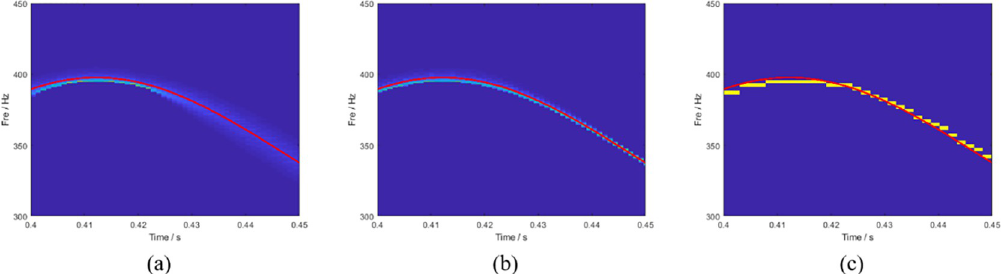
Fig 3. (a) Magnified plots of the SST, (b) RM, and (c) LMSBCT